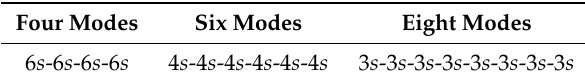
Table 1. Sensor network configurations in modal space with a fixed number of sensors. A